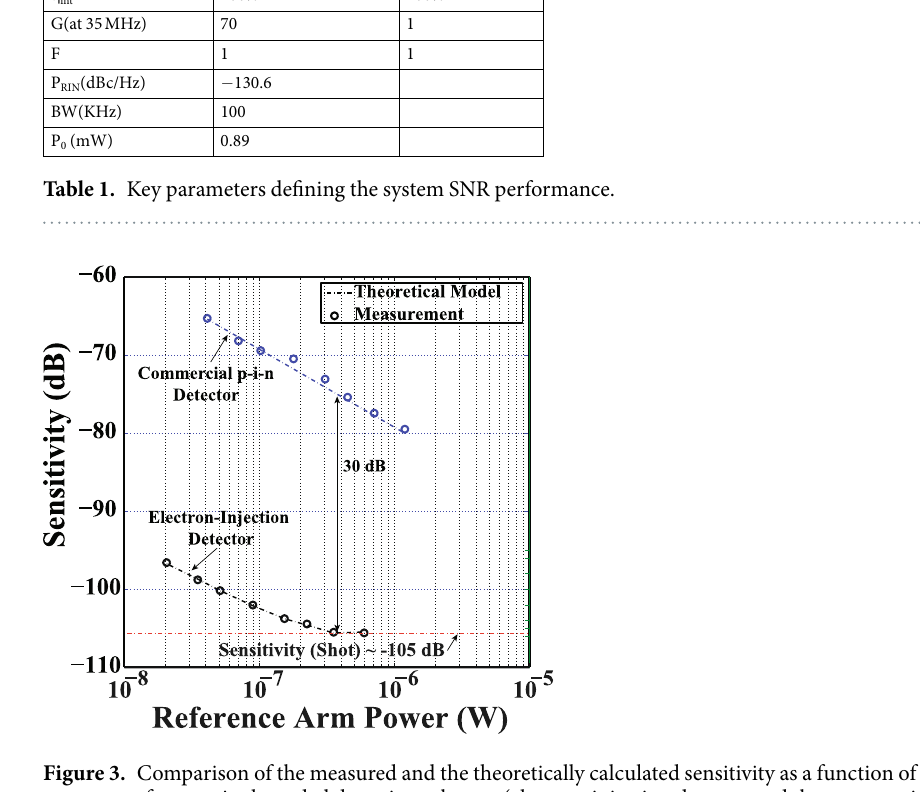
Experimentally Measured Sensitivity in SS-OCT Setup. Figure 3 shows the experimental results for sensitivities of the EI and the p-i-n detector, measured simultaneously as a function of the reference arm power at the detec- tors. To determine the optimum reference arm power, signal-to-noise-ratio of the detector was obtained from the Discrete Fourier Transform (DFT) of the sampled detector signals as a function of the reference arm power. The reference arm power at EI detector, was varied from ~20 nW to ~600 nW using the variable neutral density filter placed in front of the reference mirror. The total attenuation level of the sample arm was ~67.5 dB and the power returning from the sample at the electron-injection detector was 160 pW. The experiment was performed at a beating frequency of 35 MHz. As the reference arm power is increased, SNR increases until it reaches its maximum, dictated by the sample power returning to detector ( P s ). The gain in our device amplifies shot noise and allows it to surpass the amplifier noise at a factor of G 2 times lower reference power compared to the p-i-n detector. Utilizing the measured detector parameters provided in Table 1, in equation (4) of the “Methods” section, one can conclude that EI detector shot noise would surpass amplifier noise (also provided in Table 1), at a reference power of 350 nW. This is confirmed experimentally in our SS-OCT system. As shown by the markers in Fig. 3, the measured sensitivity of the EI detector reaches its shot-noise-limit of ~ − 105 dB (indicated by the red dotted line, and calculated from equation (7) in the “Methods” section) at a reference power level of ~350 nW. To best of our knowledge, this is the lowest reference power ever achieved for a shot-noise-limited operation in SS-OCT systems at room temperature. The typical optimum reference power level for a balanced detection system is in the few mW range 14, 15, 37 with the lowest reported value of ~15 μ W 17 . Furthermore, this is the first report of shot-noise-limited performance, without the use of balanced detection in an SS-OCT setup.